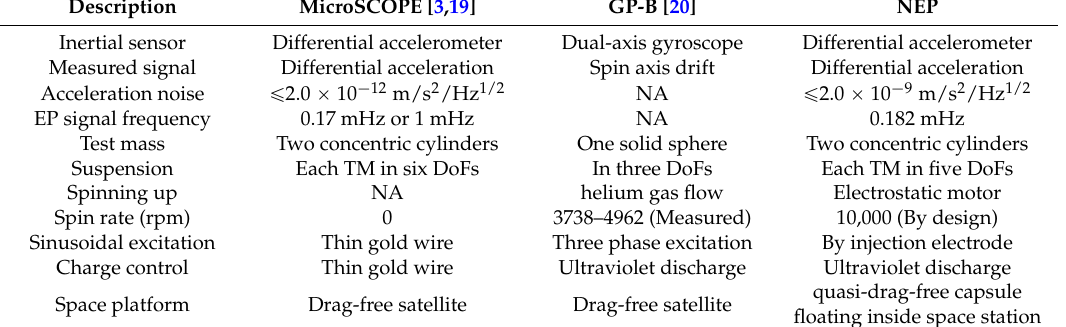
Table 1. Comparison of three inertial sensors for space-based fundamental physics experiments (NA: not applicable).